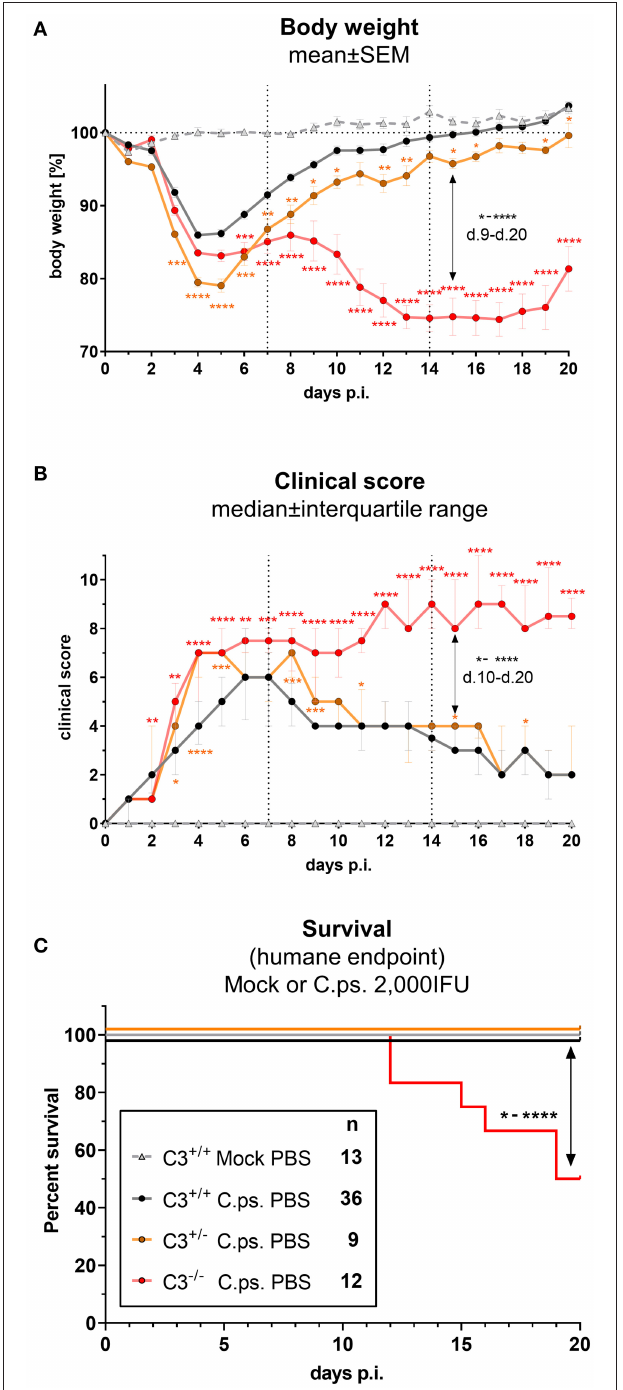
FIGURE 1 | C3 WT-levels are required to achieve optimal protection in C. psittaci mouse lung infection, but by 40%-reduced levels are sufficient to sustain critical functions. C3 + / + , C3 + / − , and C3 − / − mice were i.n. infected with 2,000 IFU of C.ps or Mock material. Body weight (A) and clinical score (B) were determined daily. Under close monitoring and using humane endpoint defining criteria survival was additionally assessed until the intended end of the experiment on day 20 p.i. (C) . C3 + / − mice showed a reduction of ∼ 40% in basal C3 plasmas level ( Supplementary Figure 1 ); in C3 − / − mice no C3